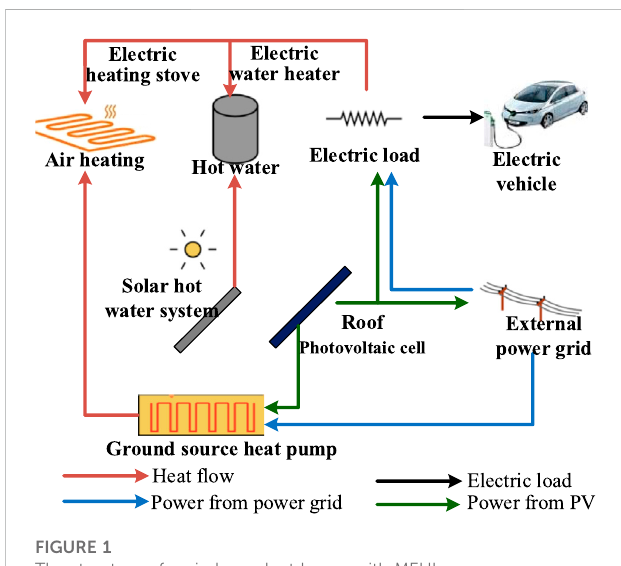
FIGURE 1 The structure of an independent house with